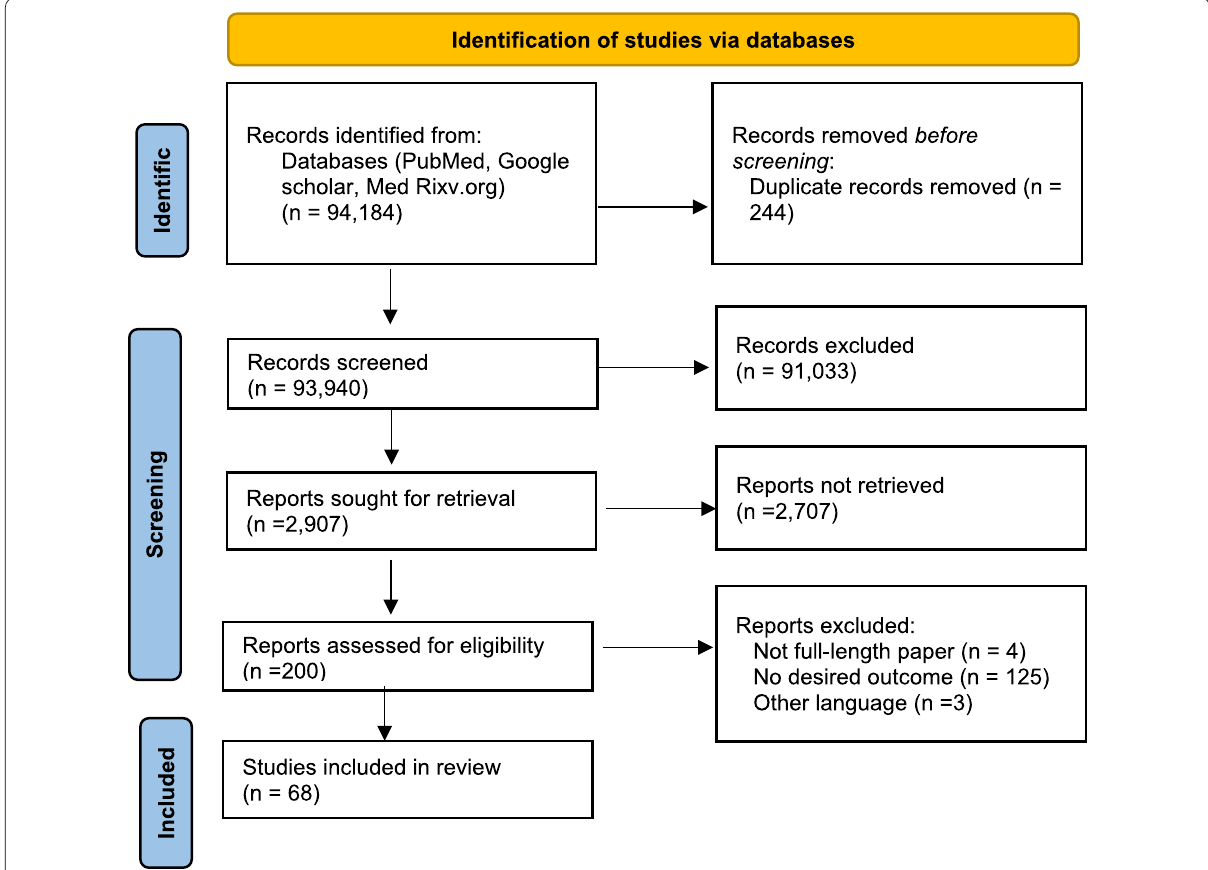
Fig. 1 Selection of studies as per the PRISMA